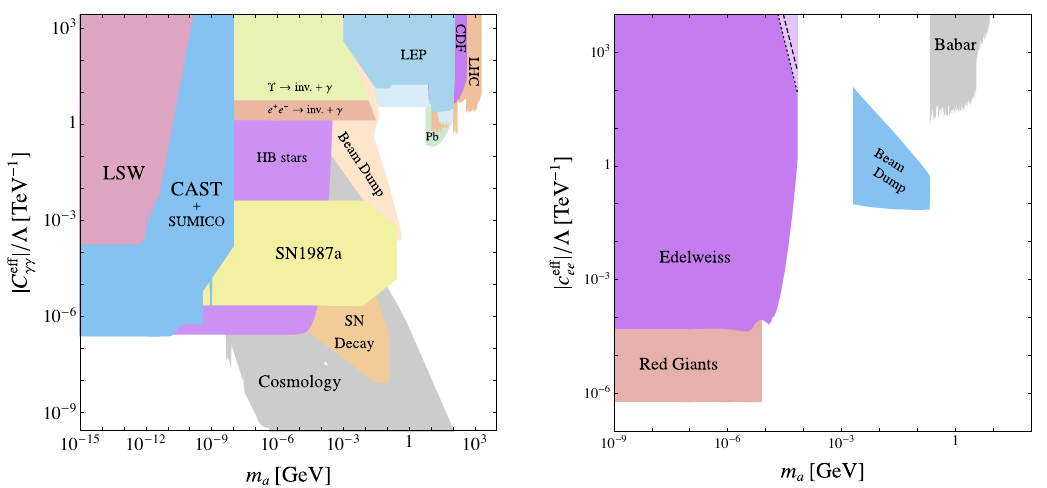
Figure 4 . Existing constraints on the ALP-photon (left) and ALP-electron coupling (right) derived from a variety of particle physics, astro-particle physics and cosmological observations. Several of these bounds are model dependent. The BaBar constraint in the right-hand plot assumes c (cid:22)(cid:22) see (3.21); otherwise, this is a bound on